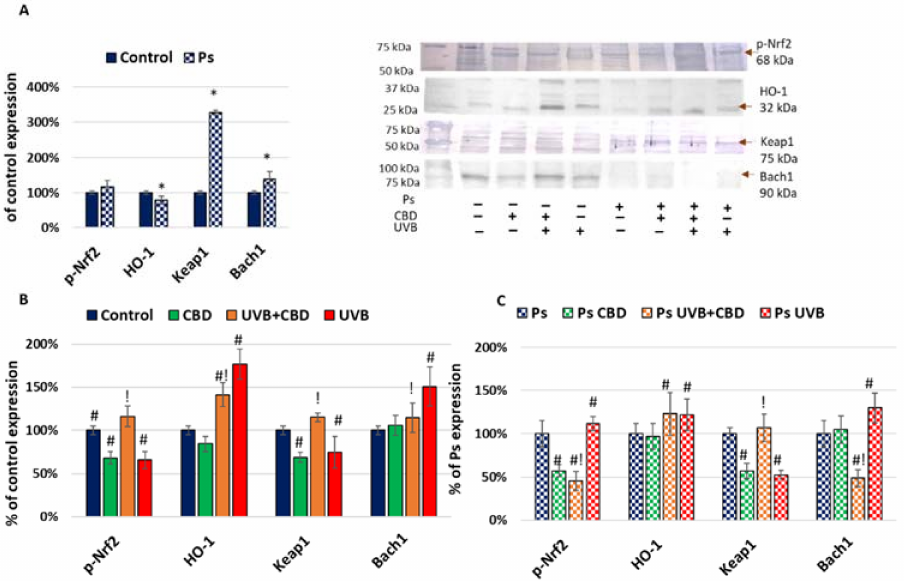
Figure 4. ( A ) Expression of proteins from Nrf2 pathway in keratinocyte cell lines from healthy subjects (Control; n = 5) and psoriatic patients (Ps; n = 5). Here, 100% corresponds to the level of protein in keratinocytes untreated with UVB or CBD. The mean values ± SD are presented with statistically significant differences: * between keratinocytes from patients with psoriasis vulgaris and healthy subjects, p < 0.05. ( B ) Expression of proteins from Nrf2 pathway in keratinocyte cell lines from healthy subjects (Control; n = 5) without treatment and after irradiation with UVB (60 mJ/cm 2 ) and/or incubation with CBD (4 µ M). Here, 100% corresponds to the level of protein in healthy keratinocytes untreated with UVB or CBD. The mean values ± SD are presented with statistically significant differences: # between keratinocytes treated with CBD, UVB and UVB+CBD and nontreated, p < 0.05; ! between keratinocytes treated with UVB+CBD and irradiated with UVB, p < 0.05. ( C ) Expression of proteins from Nrf2 pathway in keratinocyte cell lines from psoriatic patients (Ps; n = 5) without treatment and after irradiation with UVB (60 mJ/cm 2 ) and/or incubation with CBD (4 µ M). Here, 100% corresponds to the level of protein in psoriatic keratinocytes untreated with UVB or CBD. The mean values ± SD are presented with statistically significant differences: # between keratinocytes treated with CBD, UVB and UVB+CBD and nontreated, p < 0.05; ! between keratinocytes treated with UVB+CBD and irradiated with UVB, p <